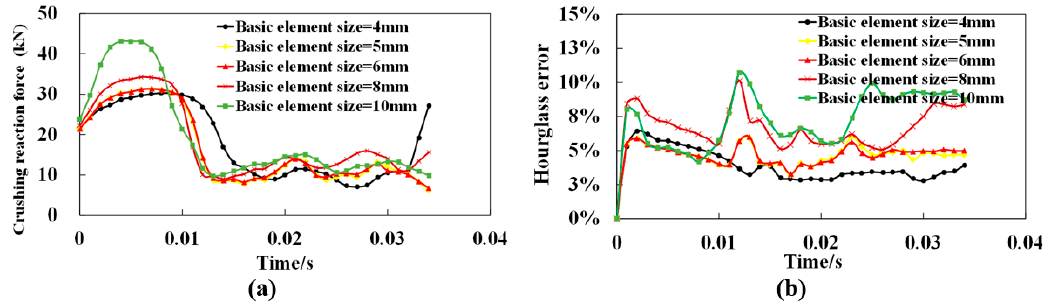
Figure 3. Convergence of the simulations under a constant velocity v c of 30 m/s with the basic element size varying from 4 mm to 10 mm: ( a ) Crushing reaction force; ( b ) Hourglass error.